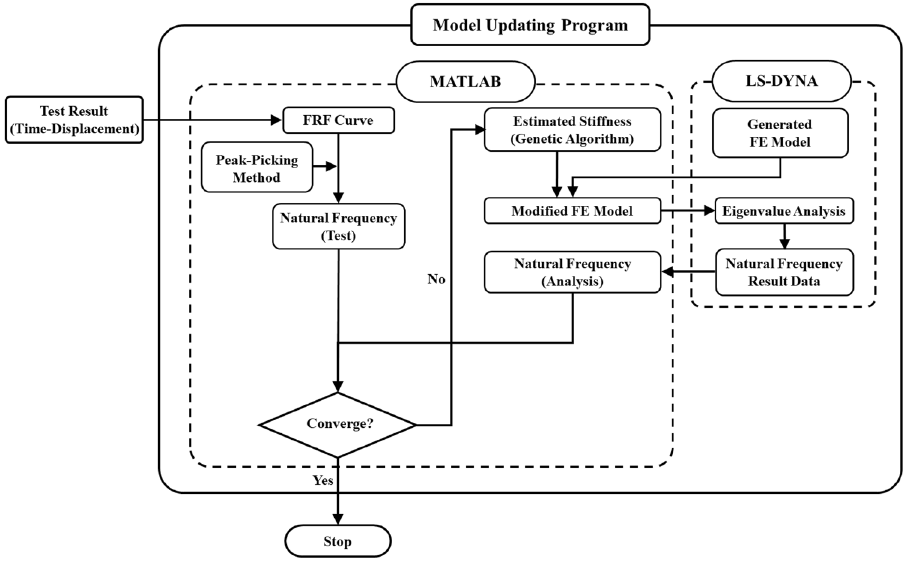
Figure 1. Flowchart for the proposed FE Model